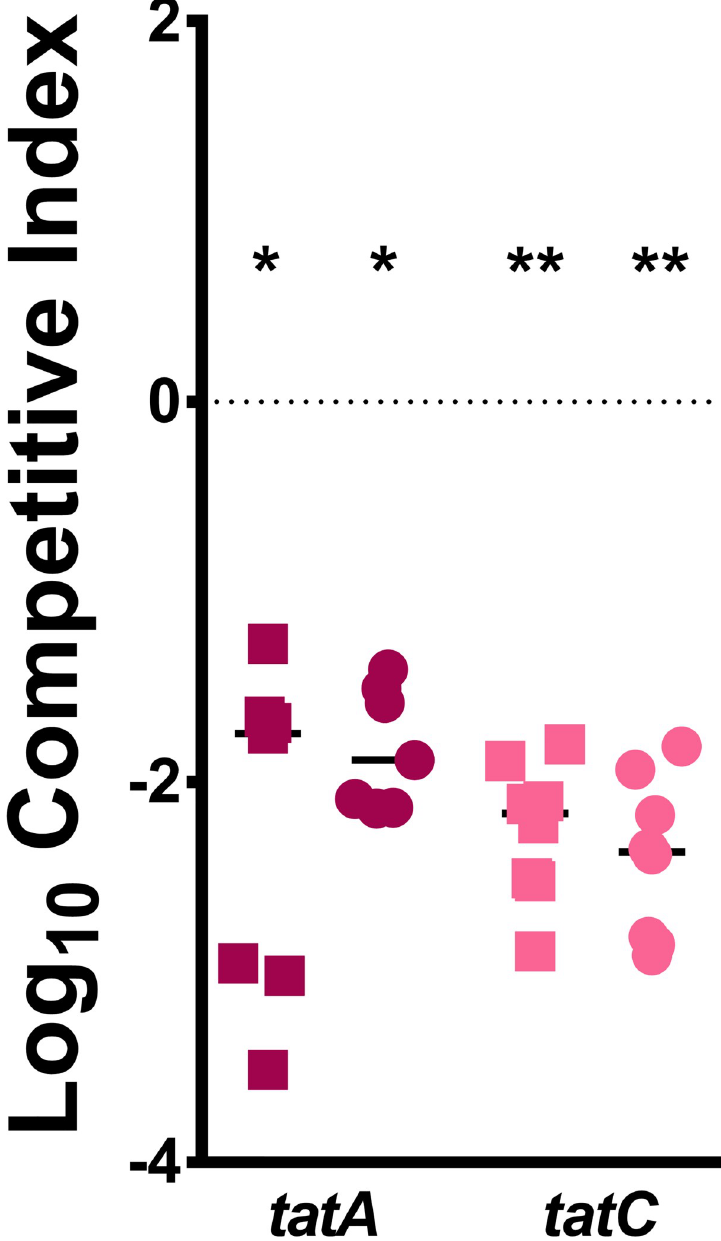
Fig 6. The Tat system contributes to P. mirabilis fitness during bacteremia. CBA/J mice were inoculated via the tail vein with 1x10 7 CFU of a 1:1 mixture of wild-type P. mirabilis and an isogenic mutant. Liver and spleen were harvested from mice 24 hours post-inoculation, homogenized, and plated on LB agar and LB agar with kanamycin. A competitive index (CI) was calculated for each mutant on a per-mouse basis for the liver (square) and spleen (circle) as described above. Data for the tatC mutant are provided from Fig 5 for comparison. Each data point represents the Log10 CI from an individual mouse. Solid lines represent the median. Dashed lines indicate a competitive index of 1, or a 1:1 ratio of mutant to wild-type. � P < 0.05 and �� P < 0.01 as determined by Wilcoxon signed rank